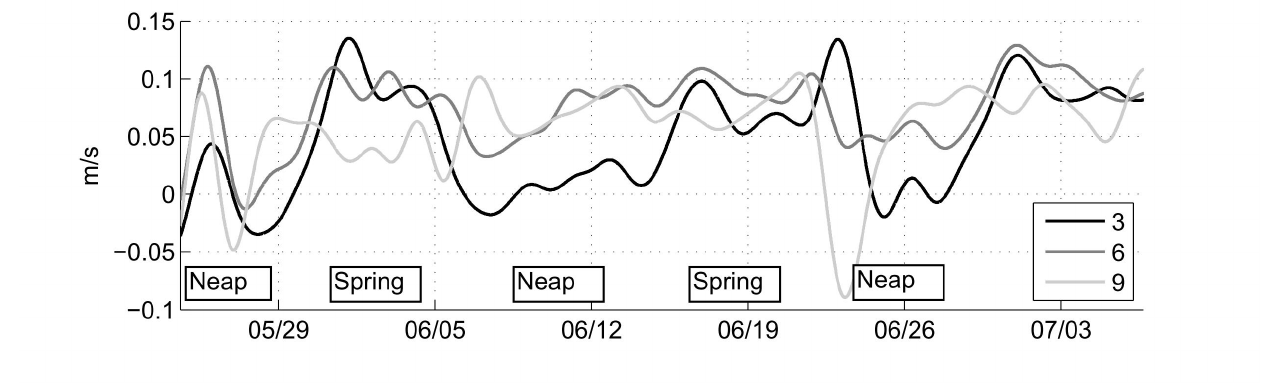
Figure 6. Butterworth low-pass filter applied on the time-series of the velocity. Shown is the residual current for the depth 3, 6 and 9 m above the